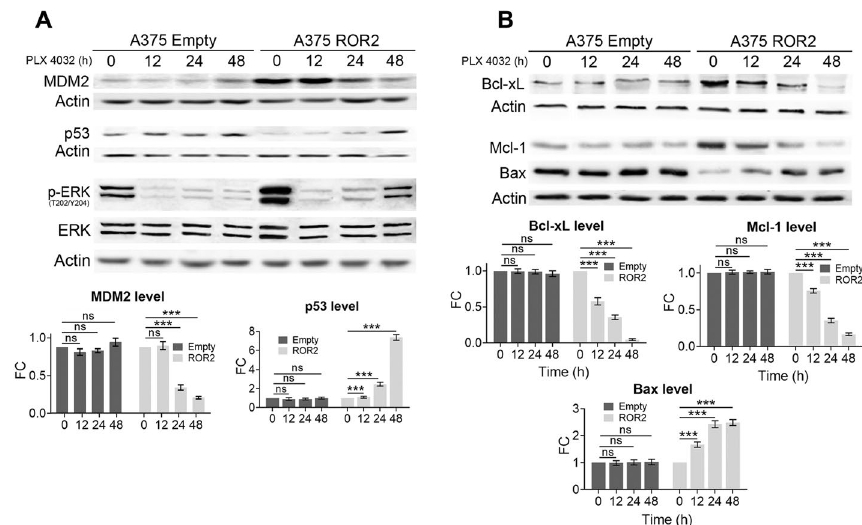
Fig. 4 ROR2 regulates the expression of MDM2, p53, and Bcl2‑family proteins through the hyperactivation of ERK. A PLX inhibited MDM2 levels and increased p53 in A375‑ROR2 cells. The cells were treated with 10 µM PLX for the indicated time. The graphs show the mean the corresponding loading control and expressed as the fold change (FC) relative to untreated cells. B Bcl2 proteins are regulated by the MAPK/ERK pathway in A375‑ROR2 cells. The cells were treated with 10 µM PLX for the indicated times. The graphs show the mean corresponding loading control and expressed as the fold change (FC) relative to untreated cells. Statistical signifcance was tested by a one‑tailed Student’s t‑test or ANOVA as appropriate (n